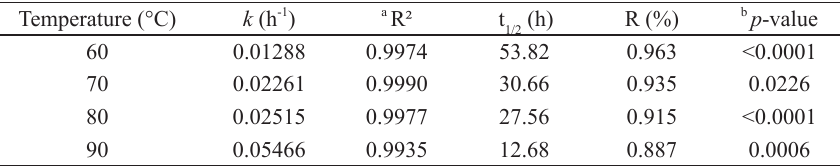
Effects of temperature on the degradation of anthocyanins as noted by the